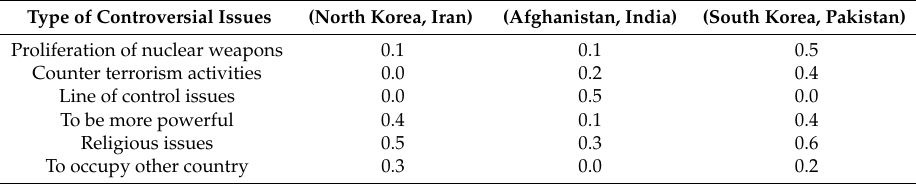
Table 10. Fuzzy set of controversial issues between some